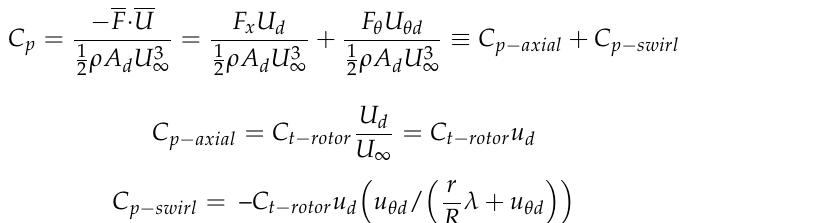
Figure 12. Rotor power coefficient versus rotor thrust coefficient for different tip-speed ratio 𝜆 .